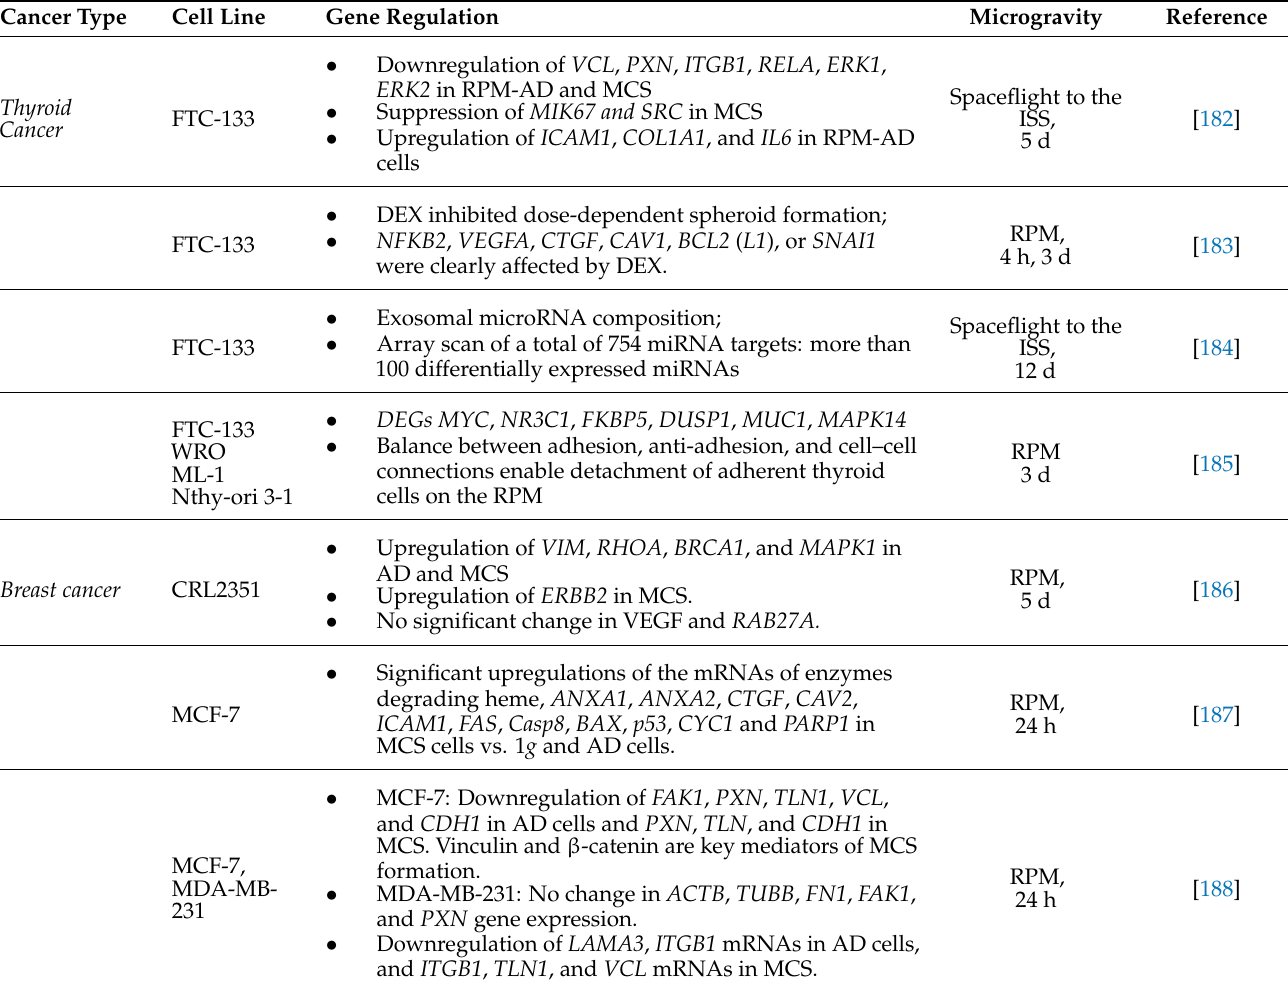
Table 9. Changes in gene regulation of different cancer cells exposed to microgravity conditions. Cancer Type Cell Line Gene